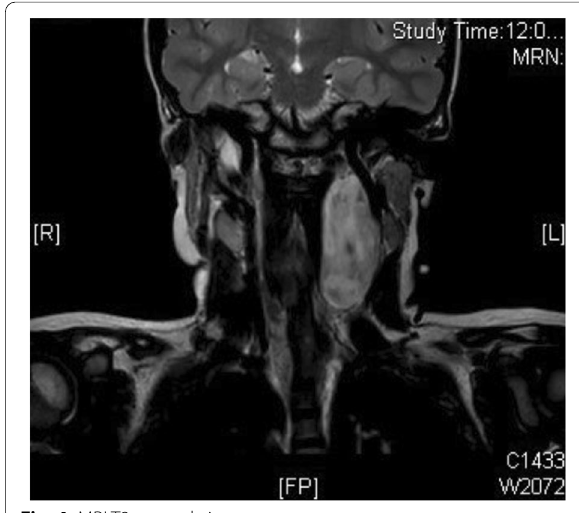
Fig. 4 MRI T2 coronal view